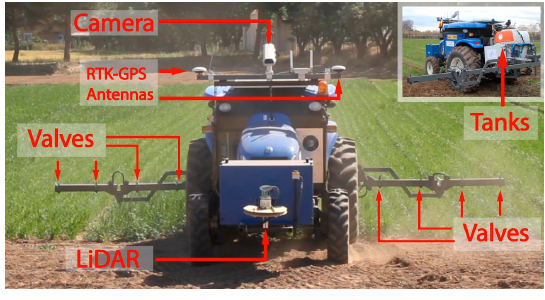
Figure 7. Ground unit.